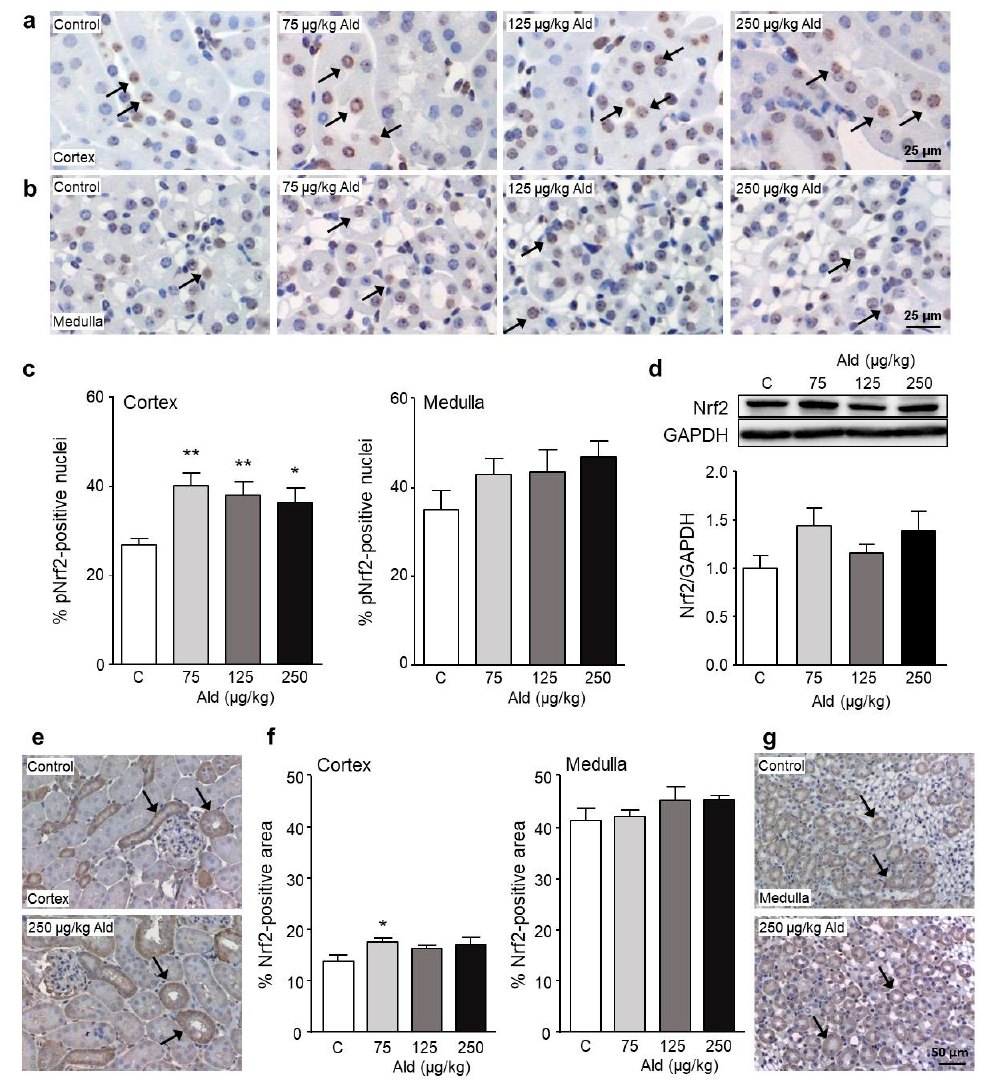
Figure 6. Induction of the transcription factor Nrf2 by aldosterone. Para ffi n-embedded kidney sections were either stained with an antibody against Nrf2 phosphorylated at Ser40 representing activated Nrf2 ( a – c ) or with an antibody against unmodified Nrf2, representing total Nrf2 protein ( e – g ). Shown are representative pictures of cortical ( a / e ) and medullary ( b / g ) kidney sections from control and aldosterone-infused animals. Examples of positive stained nuclei ( a , b ) or areas ( e , g ) are marked with black arrows. Percentage of Nrf2-positive stained nuclei ( c ) and area ( f ). For the quantification of positive Nrf2 nuclei or area, 10 visual fields of cortical and 3–5 visual fields of medullary kidney sections were analyzed per animal via Image J. ( d ) Representative picture of the Western blots of the expression of total Nrf2 (95–110 kDa) in kidneys of mice as well as the quantification of band densities of the above-mentioned protein measured via Image J and related to the housekeeper GAPDH (37 kDa). Ald: aldosterone, GAPDH: glyceraldehyde 3-phosphate dehydrogenase, Nrf2: nuclear factor-erythoid-2-related factor 2. Data are shown as mean + SEM, n = 5. * p ≤ 0.05, ** p < 0.01 vs. C: control group.